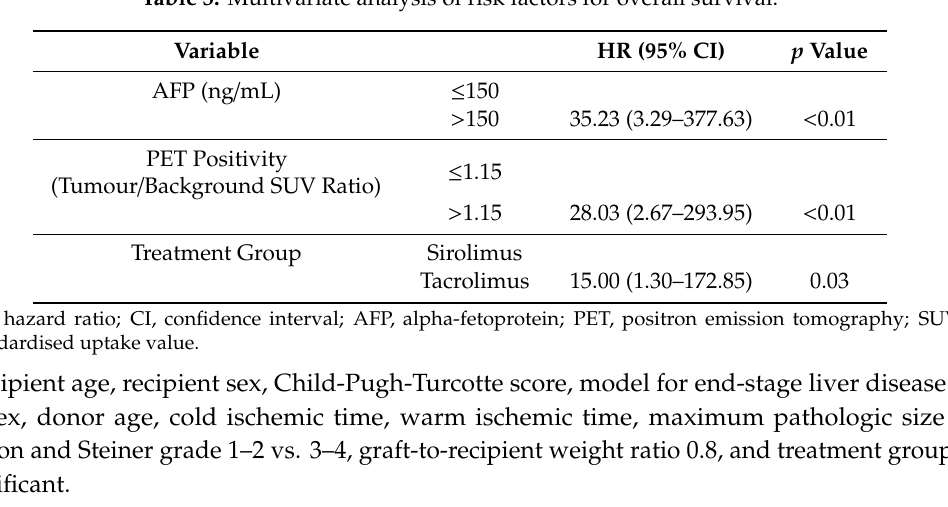
Table 3. Multivariate analysis of risk factors for overall